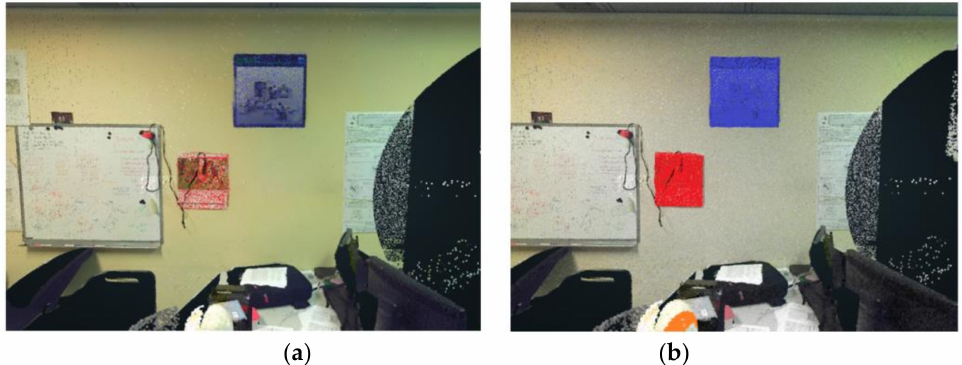
Figure 25. Influence of the panoramic image resolution on the cloud segmentation rate: ( a ) almost half of the points representing the two objects were not segmented; ( b ) almost all the points representing the two objects have been